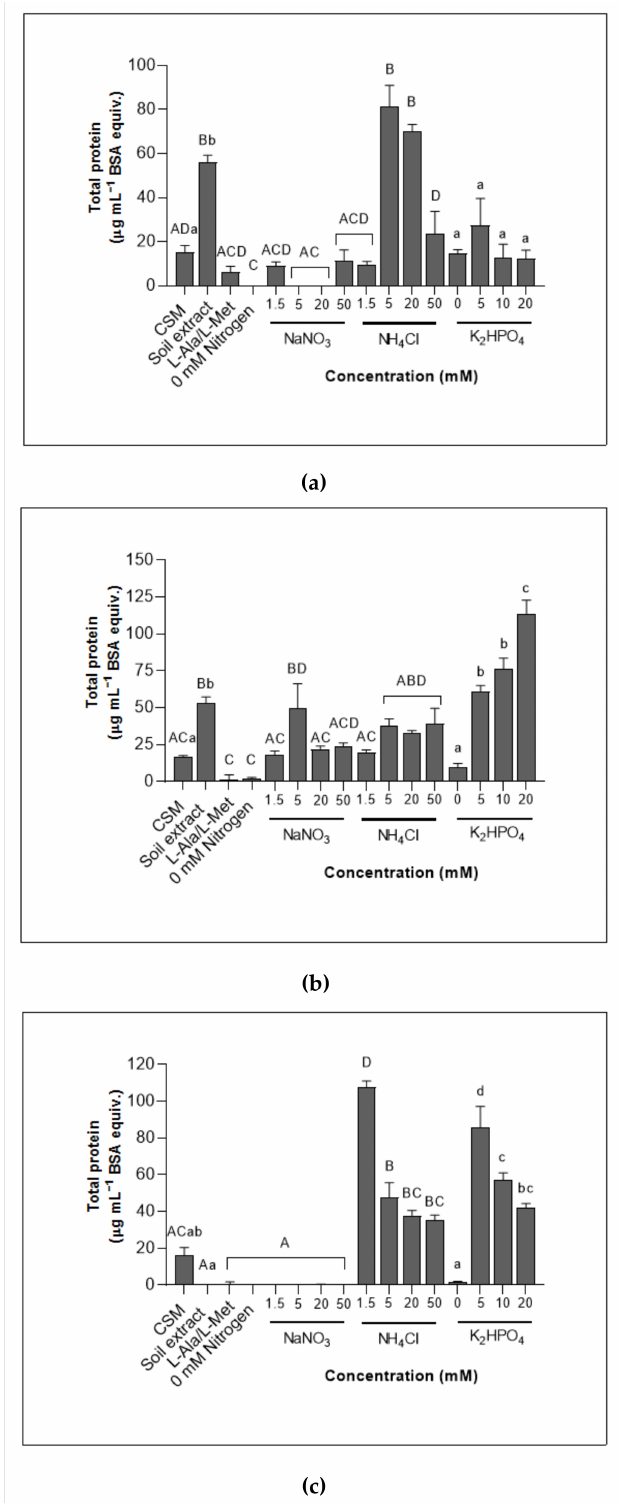
Figure 2. Biomass measured as total protein ( µ g mL − 1 BSA equivalents) at 4 weeks of growth. ( a ) G. semiglobifer ( b ) Spizellomyces sp. ( c ) R. rosea . Error bars are SEM. Significant differences in the nitrogen series are denoted by capital letters (A–D) (F 11, 177 = 48.69, p < 0.05) and lower-case letters (a–d) are used for findings in the phosphorus series (F 5, 90 = 42.52, p <